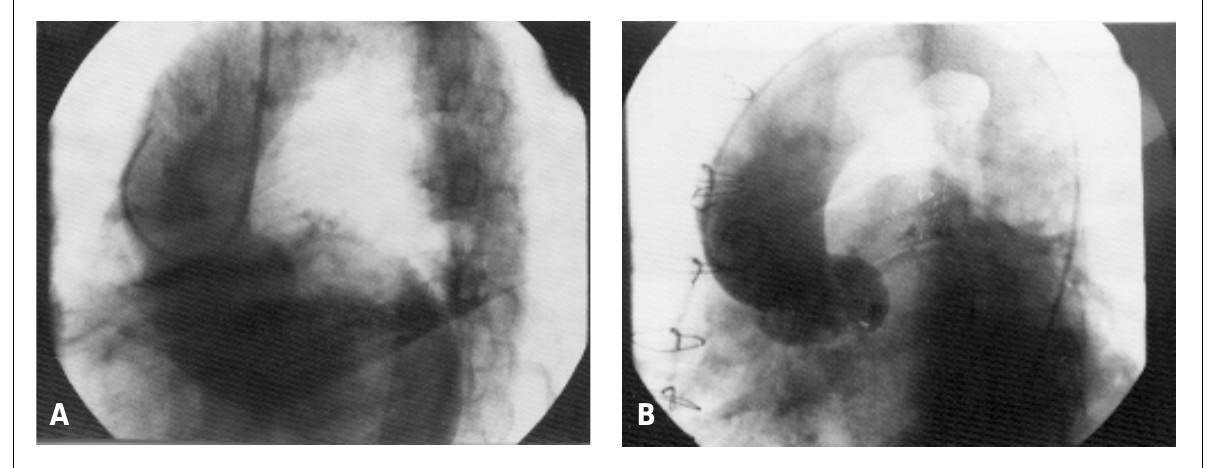
Fig. 2 – A. Aortografia pré-operatória, demonstrando insuficiência da valva aórtica. B. Aortografia pós-operatória na qual observamos competência da valva aórtica, elevação do plano valvar ao nível da nova comissura e diminuição do diâmetro da aorta ascendente ao nível do plano das